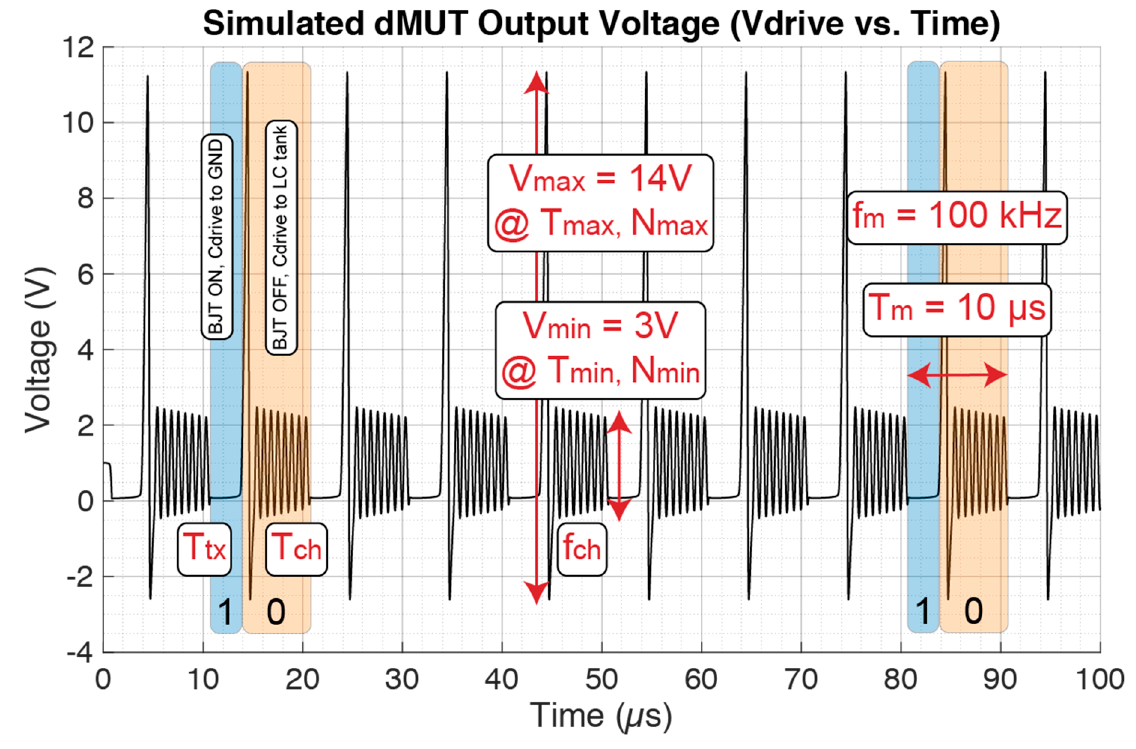
Figure 3. Simulation of the dMUT system with the values from Table 1. The blue region of period T tx indicates the transmission region there the BJT is ON and C drive is connected to ground. The orange region of period T ch instead indicates the charging region where the BJT is OFF and C drive is connected to the LC tank.